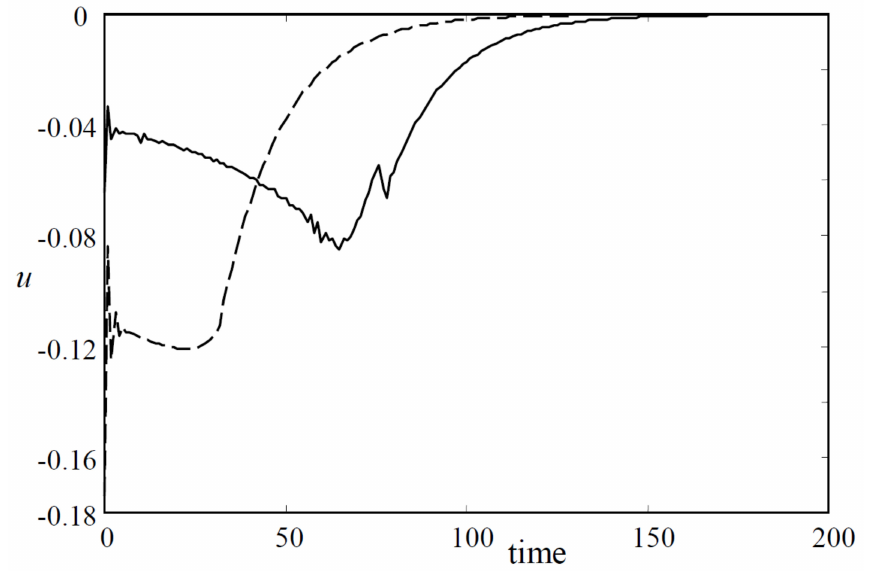
Figure 5. The input responses of the closed-loop systems (dashed line for Algorithm 1, solid Algorithm